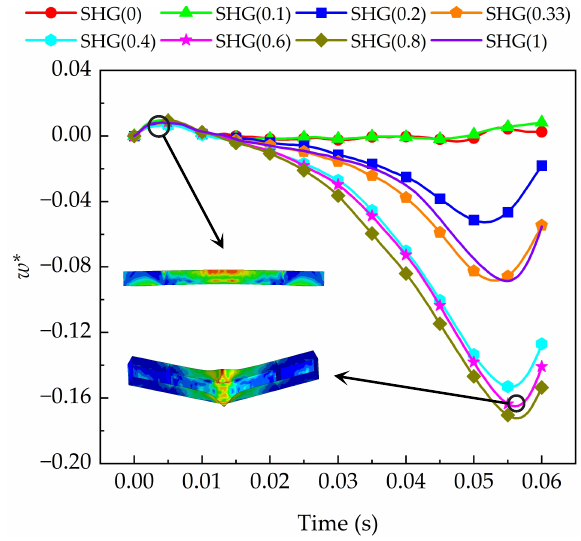
Figure 13. Time history curves of dimensionless deflection.